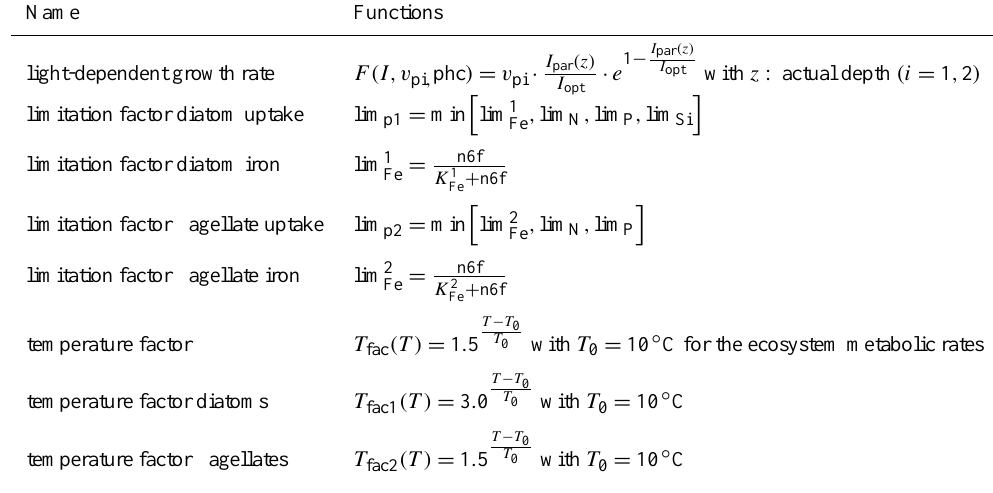
Table A4. Functions within the process parameterisations; limitation factors other than for iron in Lorkowski et al. (2012). Name Functions